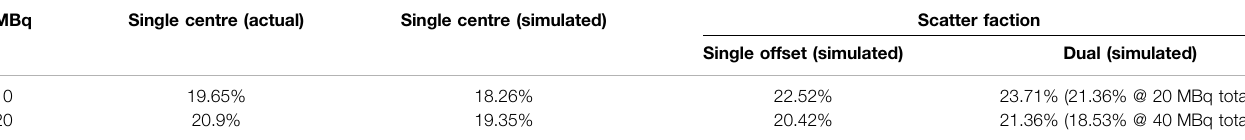
TABLE 2 | Scatter fraction for simulated off-centre and dual phantom scanning. MBq Single centre